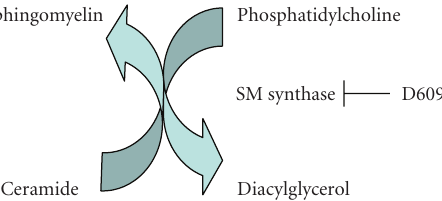
Figure 2: Sphingomyelin synthase. The reaction catalyzed by sphingomyelin synthase (SM synthase) results in a reduction in ceramide and an increase in diacylglycerol and sphingomyelin levels. The reported phosphatidylcholine-specific phospholipase C inhibitor D609 also inhibits sphingomyelin synthase